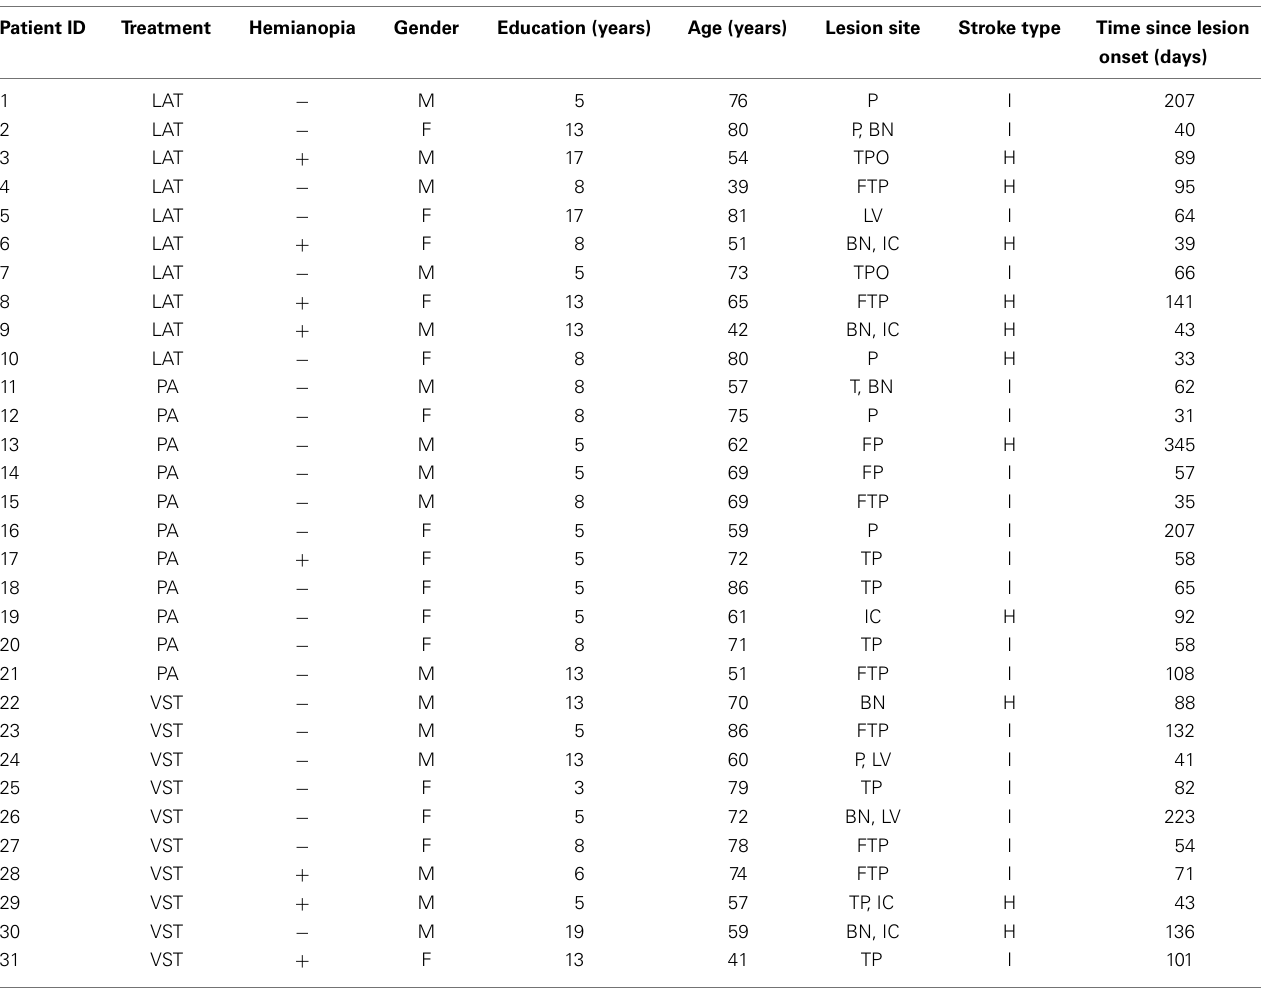
Table 1 | Demographic and neurologic data of LN